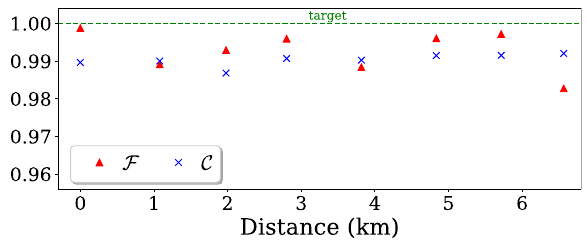
Fig. 4 | Correctness C and fairness F measured in our experimental imple- mentation of the protocol with honest parties, for different communication distances. The dashed line gives the target value for an ideal